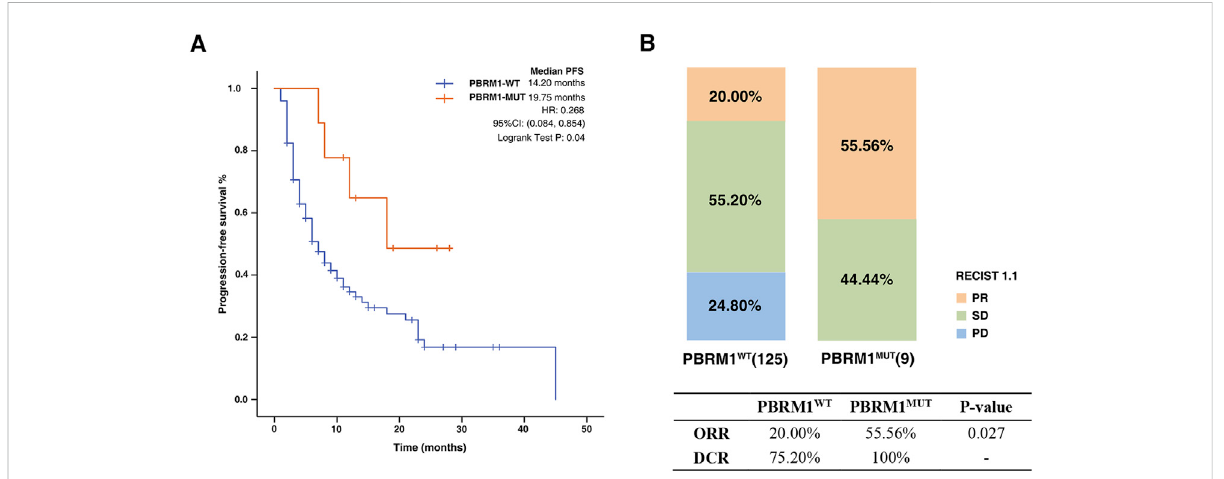
FIGURE 4 Association between PBRM1 mutation and ICIs ef fi cacy in NSCLC cohort. (A) The Kaplan-Meier survival analysis comparing PFS between PBRM1-MUT and PBRM1-WT patients in NSCLC cohort. (B) Histogram depicting proportions of ORR and DCR in PBRM1-MUT and PBRM1-WT